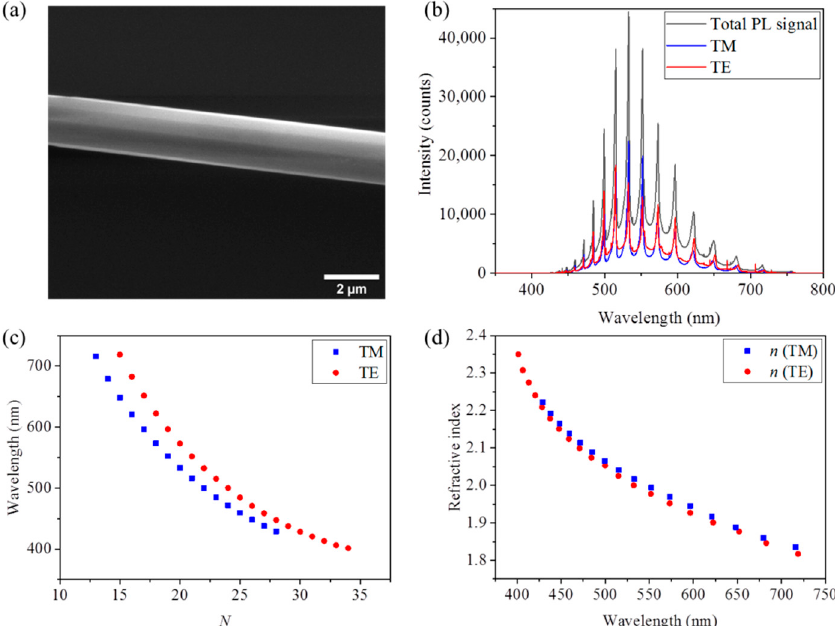
Figure 9. Analysis of the whispering gallery modes in region (ii) of the nail. The side length “a” measured in the ( a ) SEM images was 1.04 µm. ( b ) µ-PL spectra for all the polarization conditions, ( c ) interference order N of the peaks observed in the spectra, and ( d ) estimation of refractive index from the wavelength, which virtually overlapped for both polarizations.